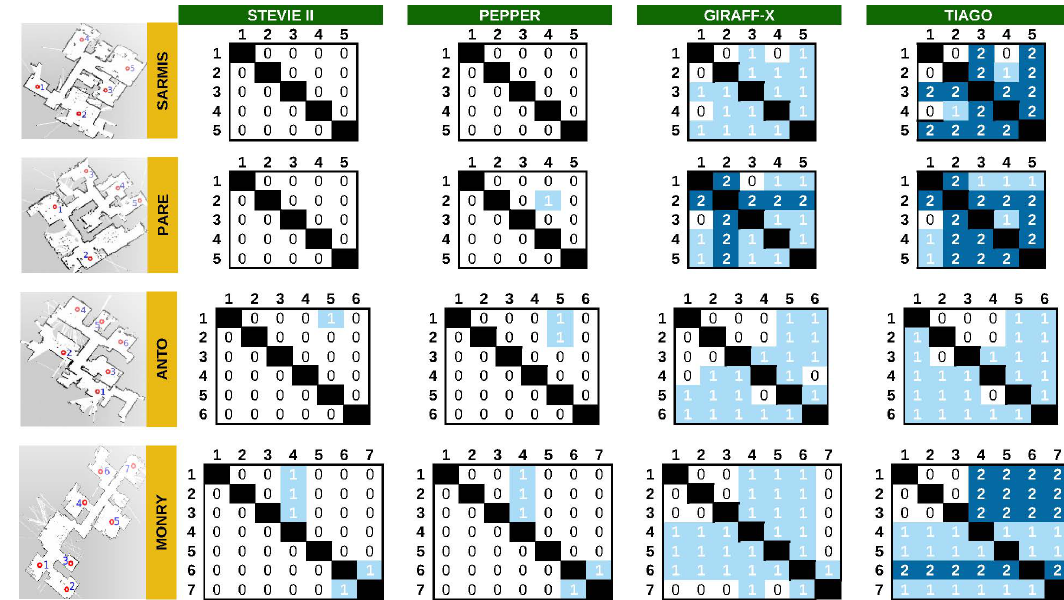
Figure 6. Navigation results for the different robots and test environments. The results are labeled as 0: no CNP detected, navigation without error, 1: one or multiple CNPs detected, navigation successful only after considering the ANPs, or 2: one or multiple CNPs detected but navigation failed even after considering the ANPs.